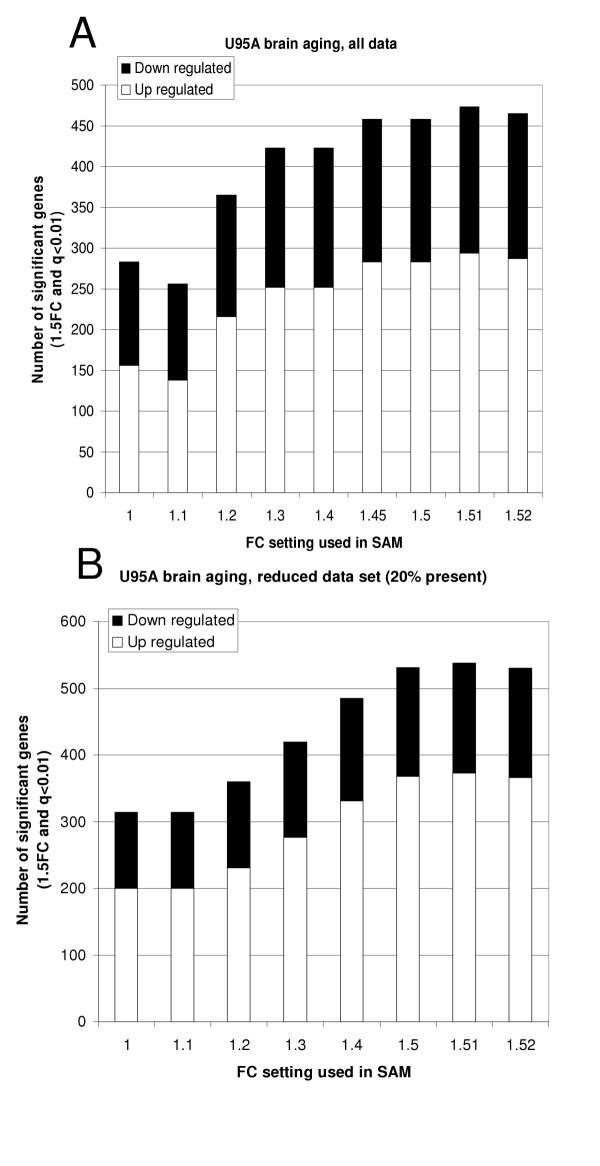
FC effects on the brain aging data set: SAM analysis at various fold changes using the brain aging data set (11 old samples and 10 young samples) while scoring genes with a q-value of <0.01 and FC>1.5. We used both the full data set and the reduced data set suggested by the authors. (A) The full data set. (B) The reduced data set (20% "present" calls by D-chip").